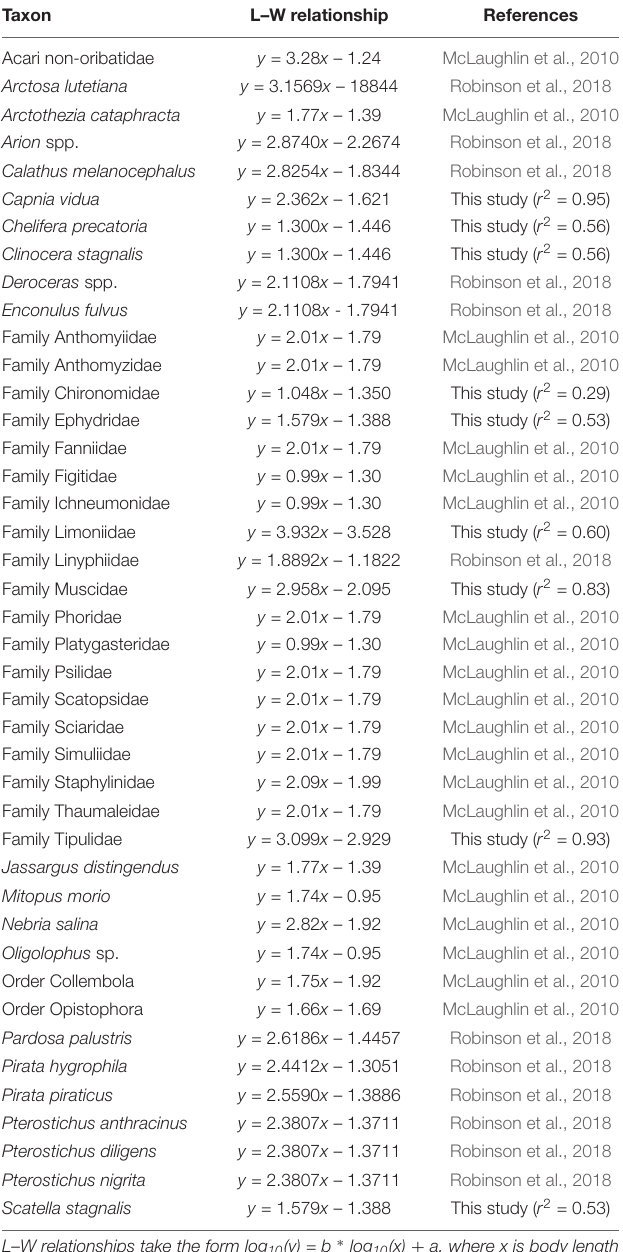
TABLE 1 | Length–weight (L–W) relationships for estimating the body mass of invertebrate taxa sampled in the